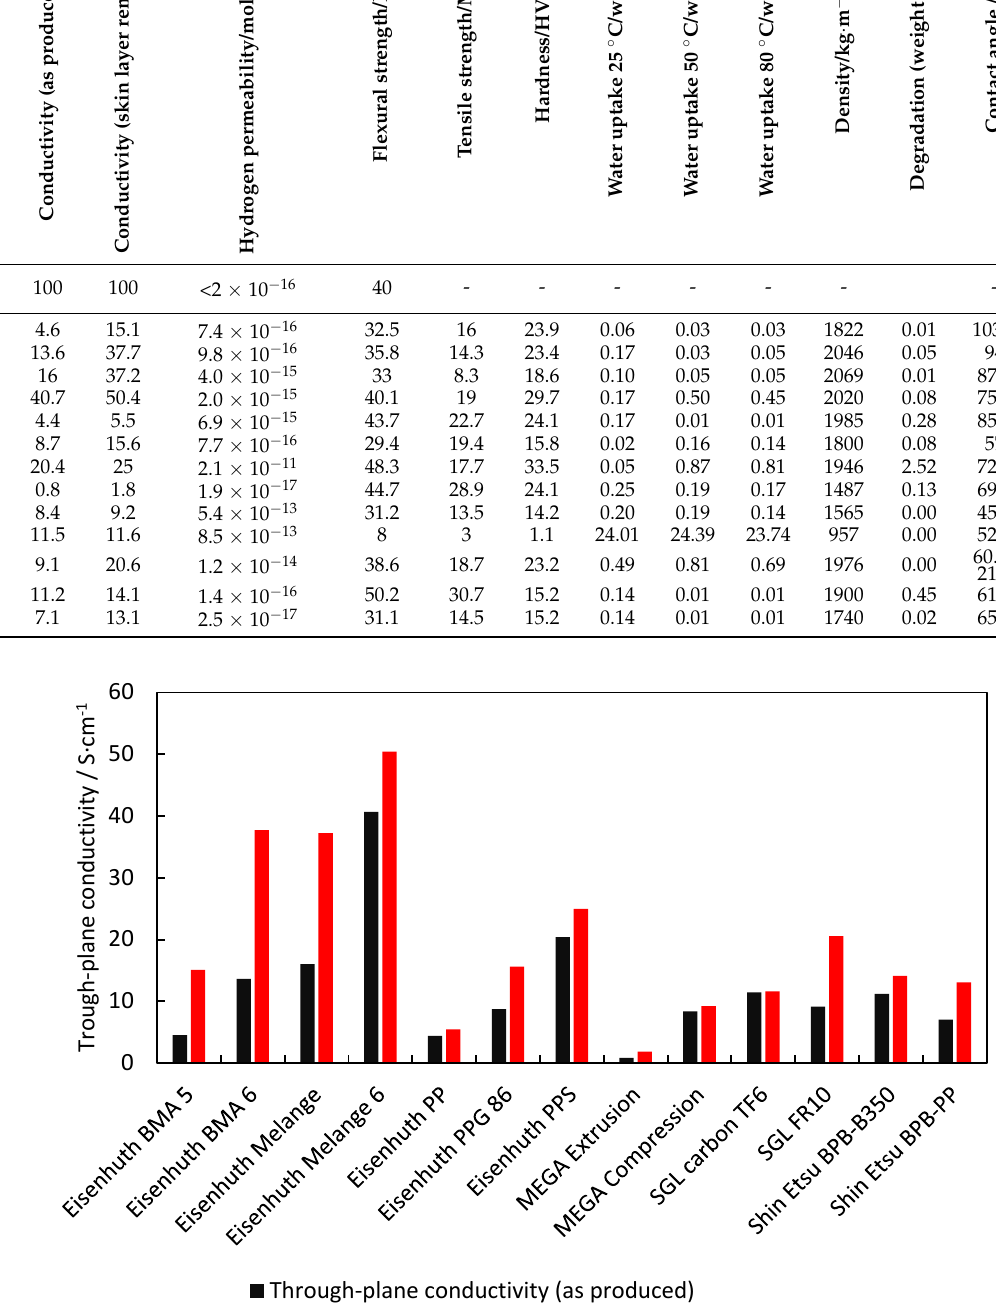
Through-plane conductivity (as produced) Through-plane conductivity (with skin layer removed) Figure 5. Through-plane electrical conductivity of the BPs tested.